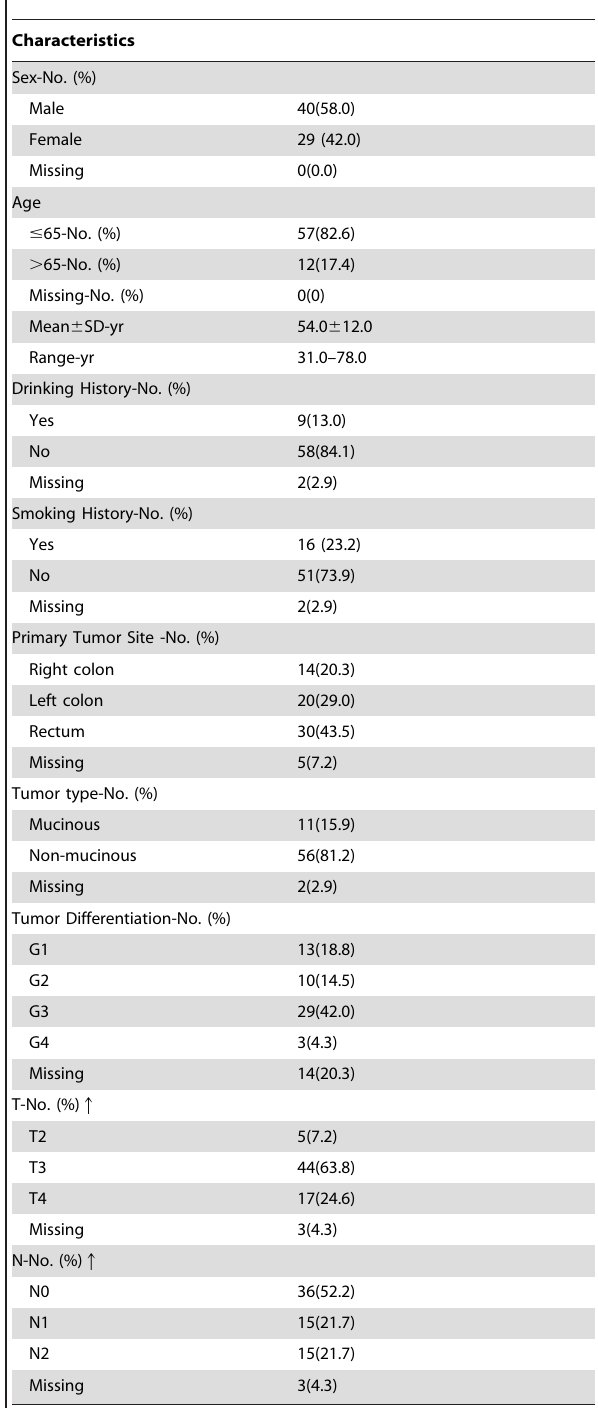
Table 1. Characteristics of 69 patients with metastatic colorectal